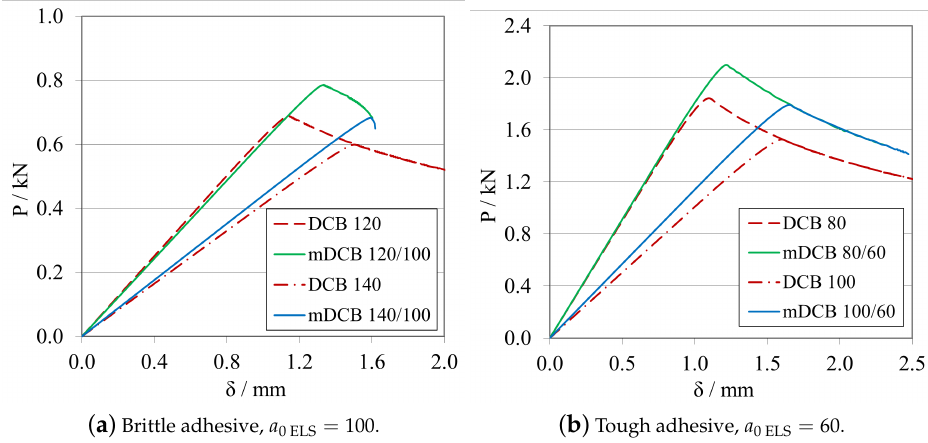
Figure 24. P - δ curves related to fixed a 0 ELS , dependent on the adhesive, and a 0 ELS < a 0 mDCB , compared against the correspondent standard